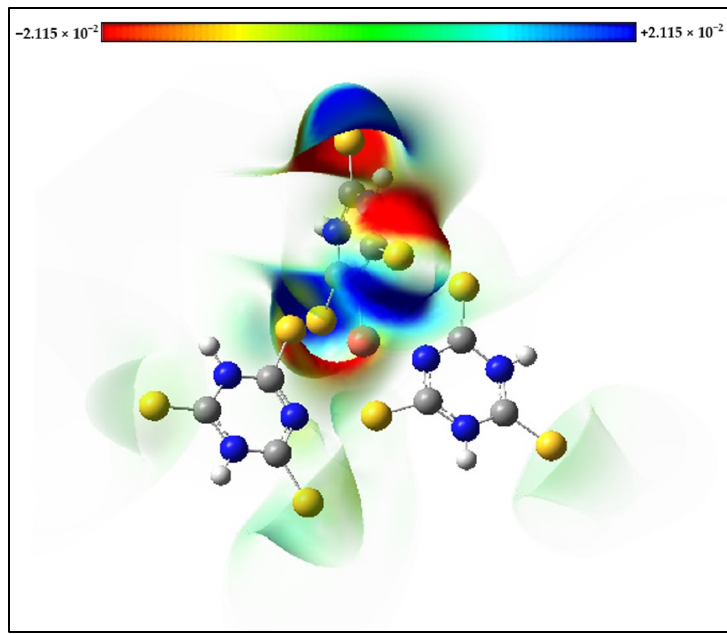
Figure 10. Molecular Electrostatic Potential (MEP) maps of the s -Cu-TTC.